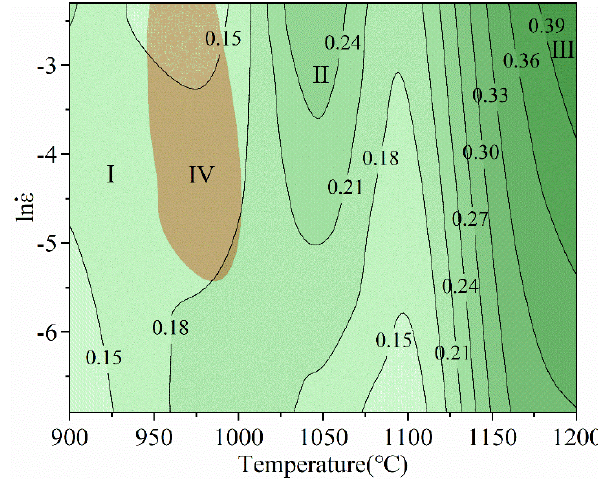
Figure 8. Processing map for SJTU-1 alloy at a strain of 0.5.